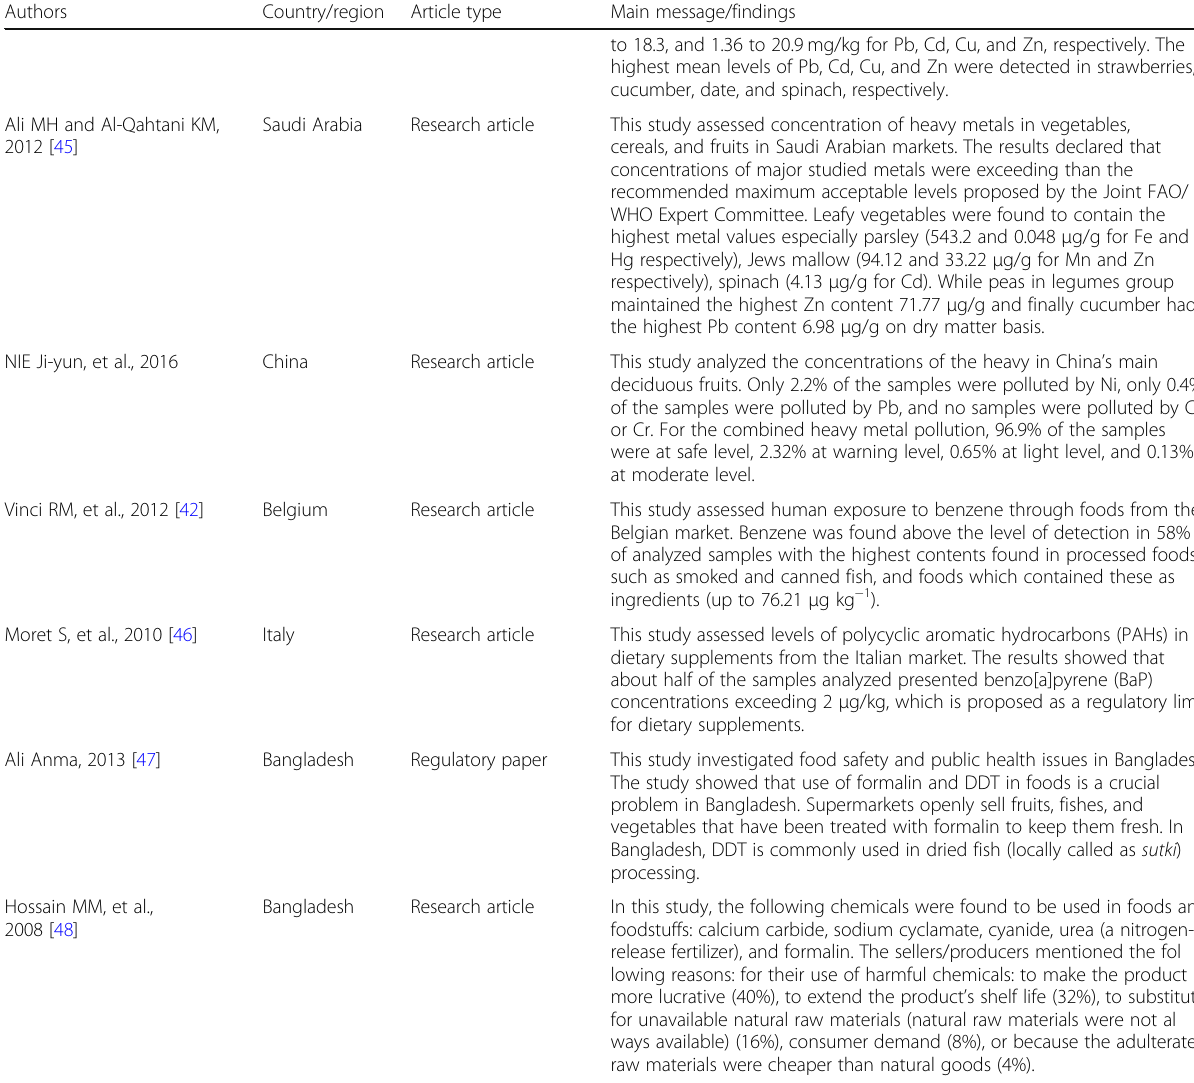
Table 4 Summary of full-text articles which reported chemical contamination of foods as a public risk in food marketing